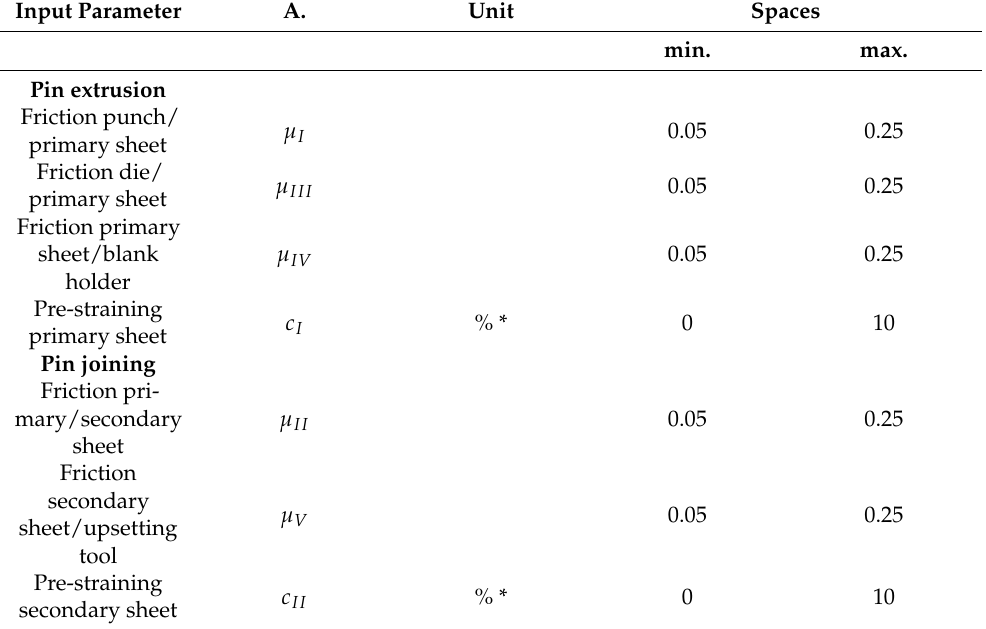
Figure 9. The comparison of a low and high friction coefficient µ V (c.f. Table 1) between the upper upsetting tool and aluminium joining partner.